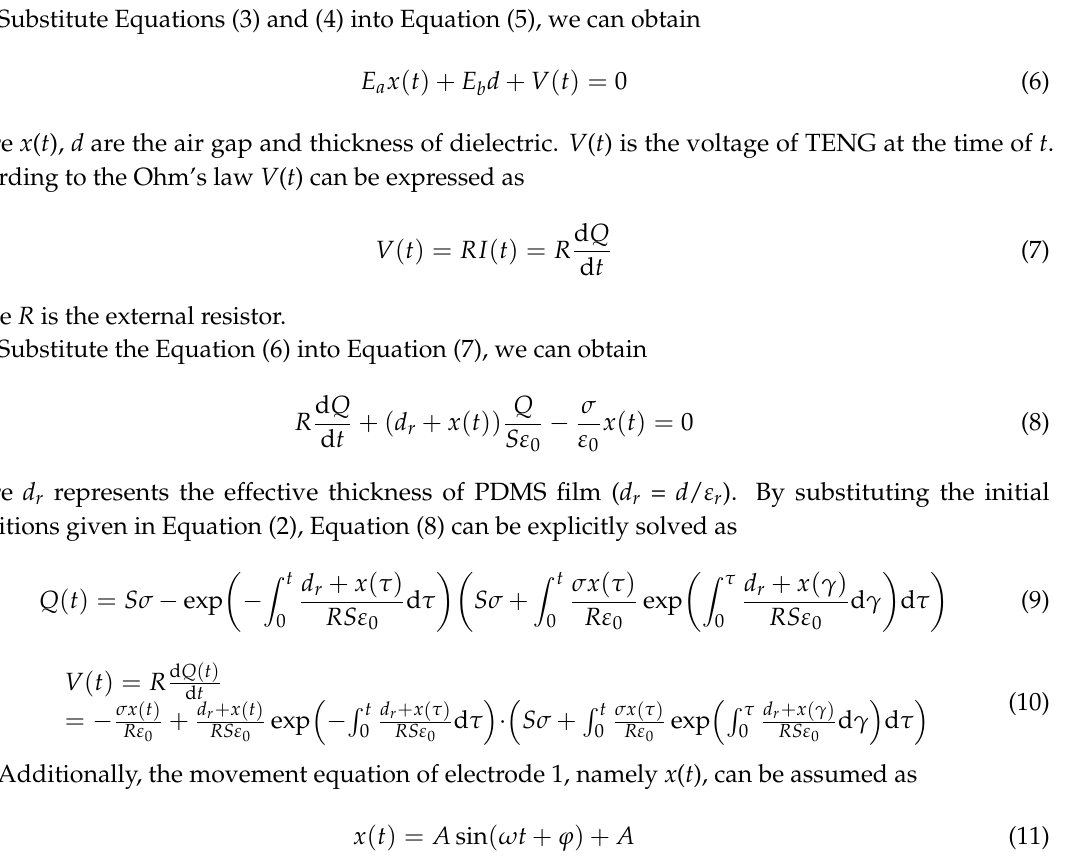
Table 2 listed all the experimental parameters used in solving Equation (10), and by using Mathematica software © (Wolfram, Somerville, MA, USA), the explicit output voltage vs. time curves can be